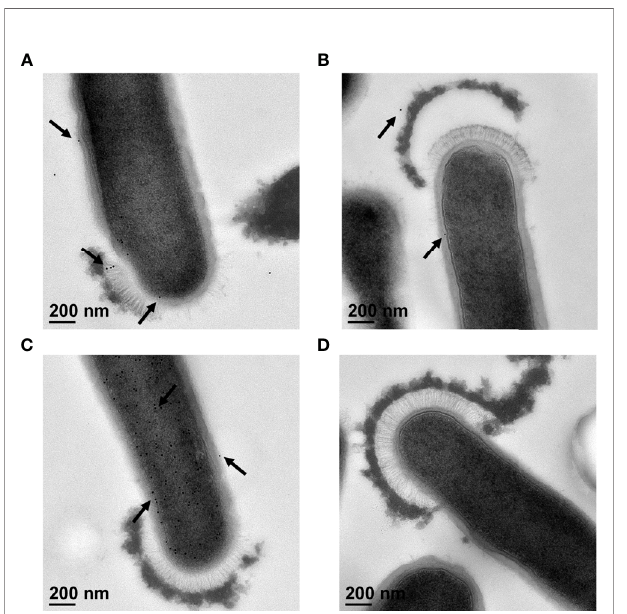
FIGURE 5 | Immunogold staining of L. johnsonii N6.2 whole cells. Representative TEM images of immunogold staining of anti-Sdp_SH3b2 (A) , anti-Sdp_SH3b6 (B) , anti-Eno3 (C) and anti-LexA (D) . Black arrows indicate location of 12 nm gold particles that appear as black round dots.